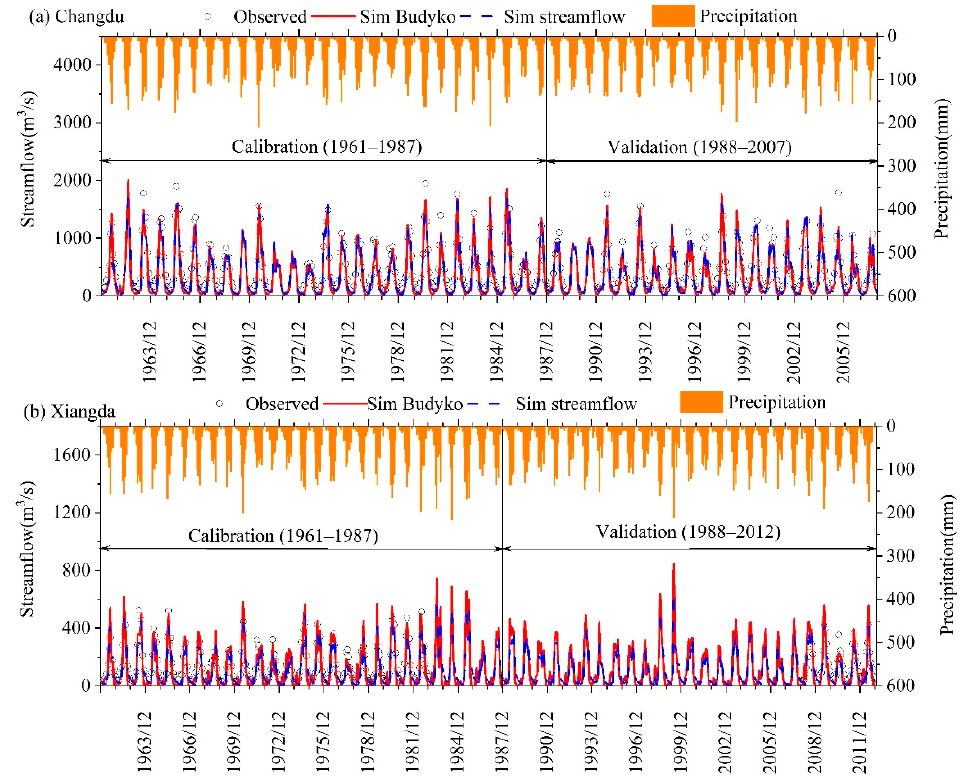
Figure 5. Observed and simulated monthly streamflow for different calibration approaches((Sim Budyko, Sim Streamflow, Non-calibration)) in the UL-MR. (a) Changdu hydrological station; (b) Xiangda hydrological station.